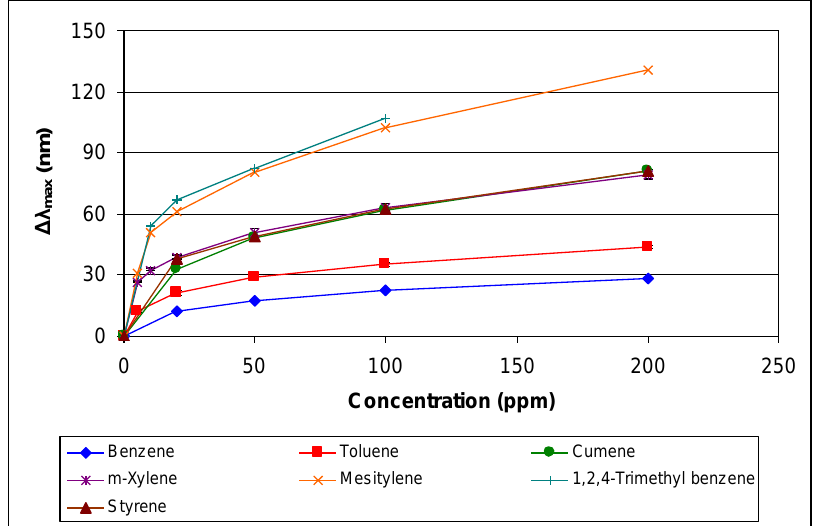
Figure 6. Response of sensor to aromatic hydrocarbons at various